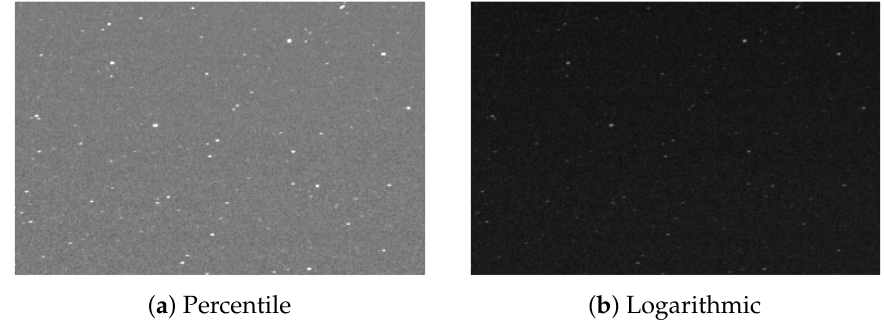
Figure 1. Examples of FITS images converted to JPEG using different methods.